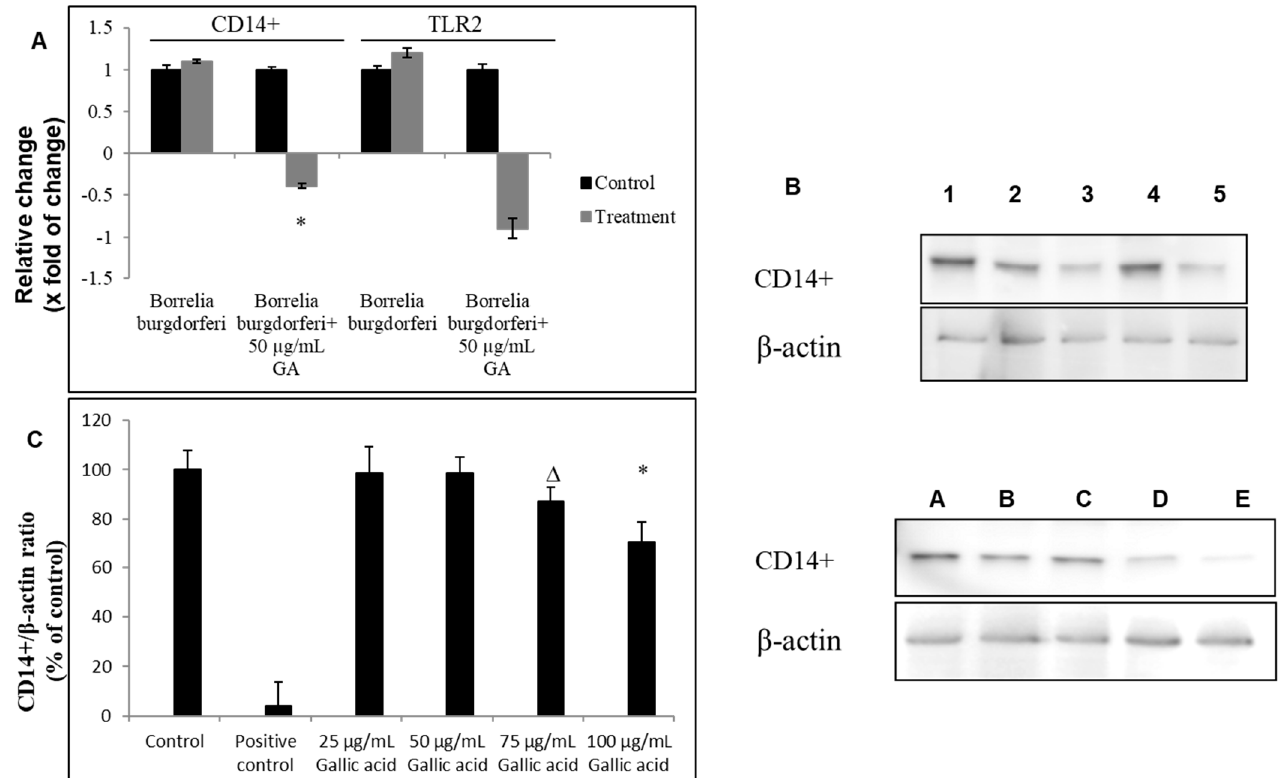
Figure 6. Effect of gallic acid on toll-like receptor 2. Human CD14 + monocytes were treated with gallic acid (GA) upon B. burgdorferi 31 stimulation. Levels of proteins were assessed by RT-qPCR ( A ) and Western blot ( B ) after 12 h post-treatment. Densitometry of Western blot bands ( C ). 1—control cells not stimulated with B. burgdorferi ; 2—control cells stimulated with B. burgdorferi at cells:bacteria 1:5 ratio; 3—cells stimulated with B. burgdorferi at cells:bacteria 1:5 and treated with gallic acid at 50 μ g/mL; 4—cells stimulated with B. burgdorferi at cells:bacteria 1:10; 5—cells stimulated with B. burgdorferi at cells:bacteria 1:10 and treated with gallic acid at 50 μ g/mL; A—control cells not stimulated with B. burgdorferi ; B—control cells stimulated with B. burgdorferi at cells:bacteria 1:5